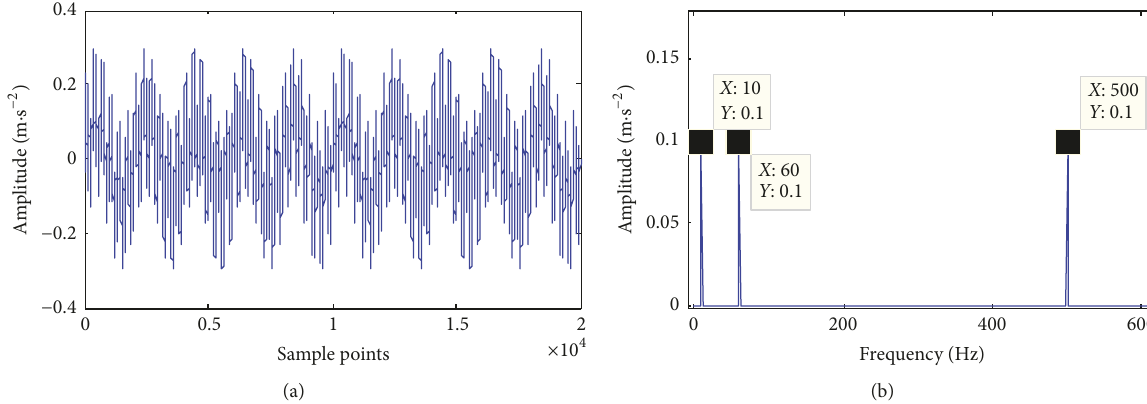
Figure 4: The time domain and spectrum of the simulated signal with the 𝐷 = 0